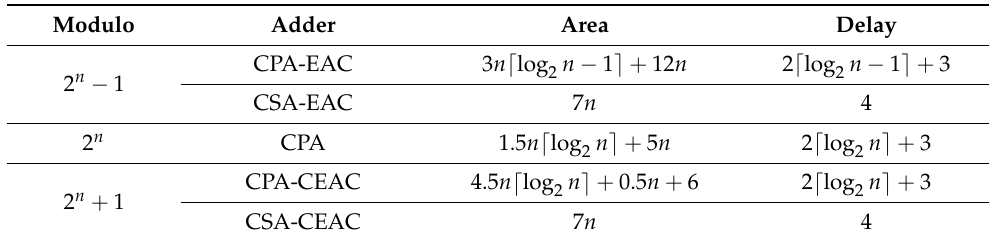
Table 1. The area and delay formulas for different n -bit modulo adders based on the U-G model reported in